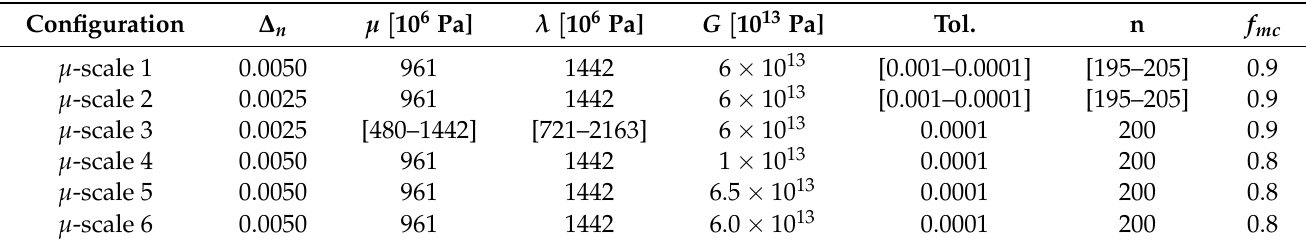
Table 1. Micro-scale parameters used in the different parametric studies.